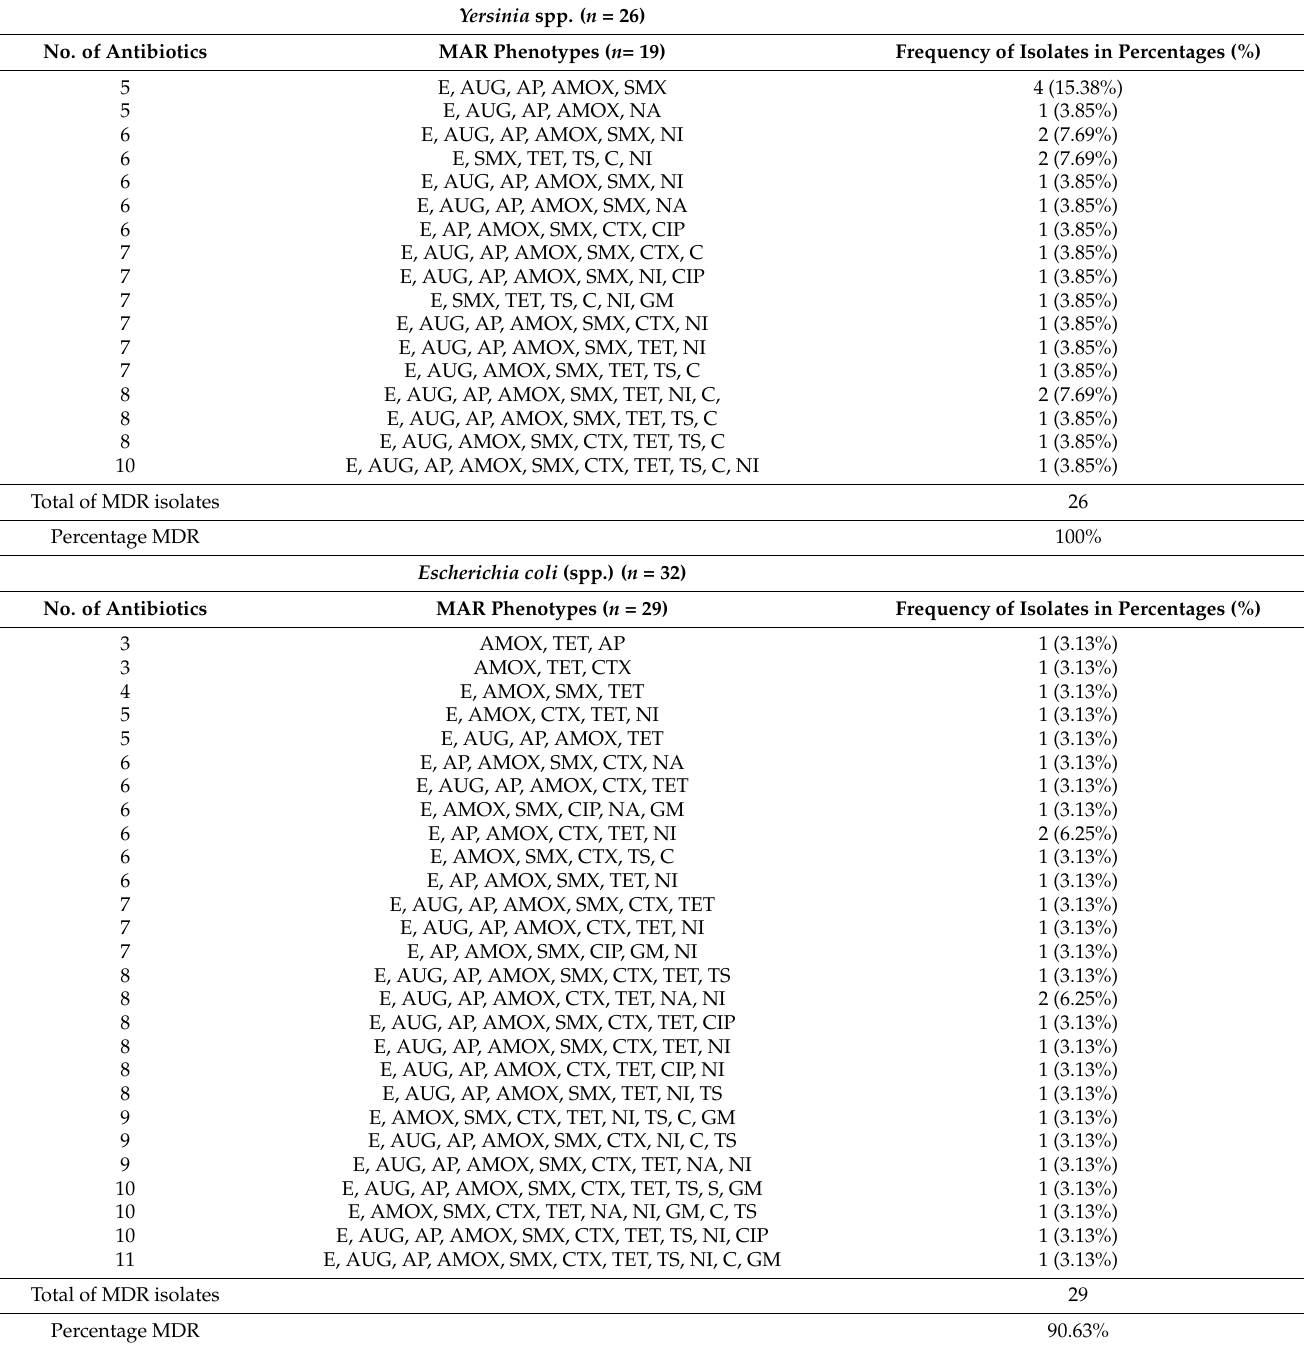
Table 3. Resistance patterns observed in the multidrug-resistant bacterial isolates. Yersinia spp. ( n =